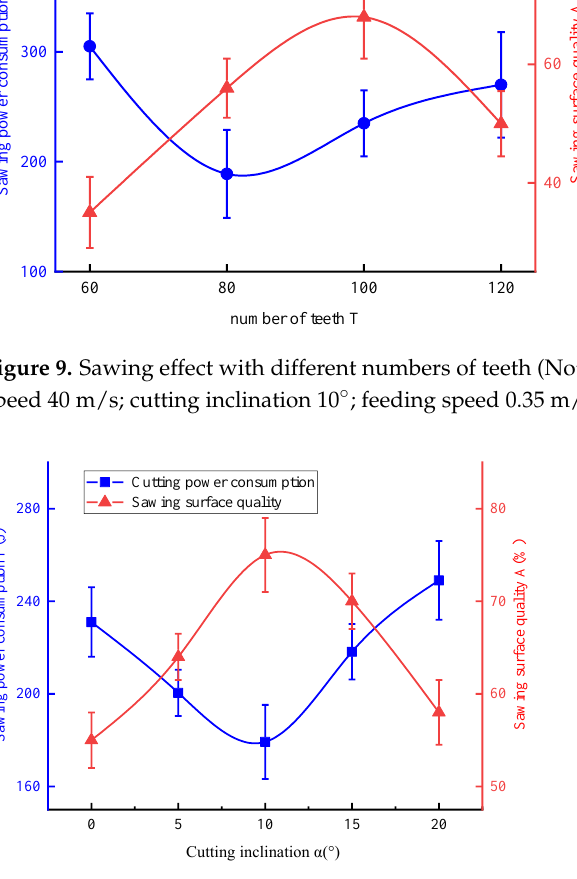
Figure 10. Sawing effect with the different cutting inclination (Note: Branch diameter 10~12 mm; sawing speed 40 m/s; feeding speed 0.35 m/s; number of teeth 80; moisture content 25.0~29.9% ).